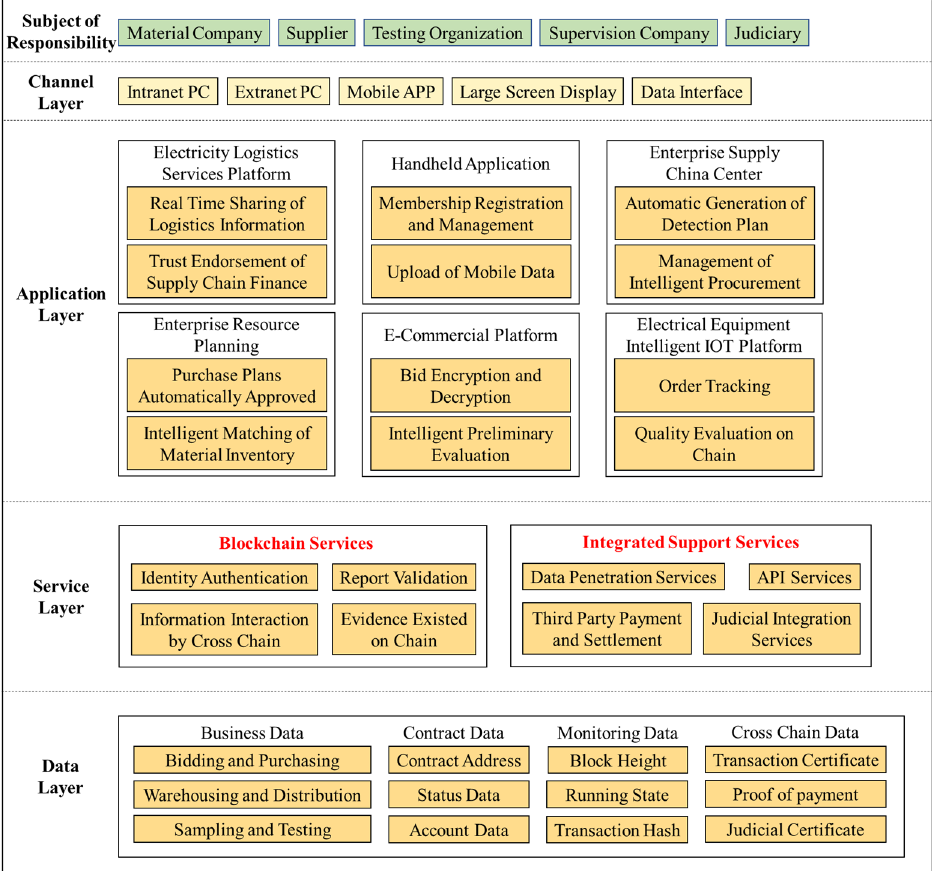
Figure 3. Blockchain-based application structure of the power material supply chain.